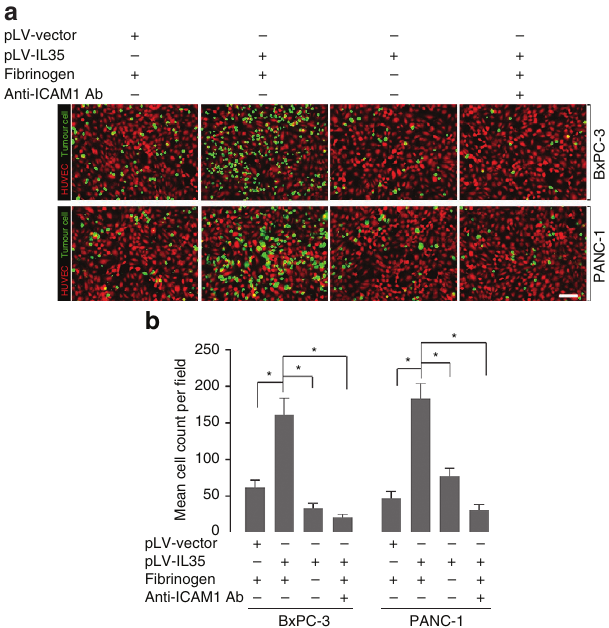
Figure 4 | ICAM1 facilitates adhesion to HUVECs via the ICAM1– fibrinogen–ICAM1 bridge. ( a , b ) HUVECs stained with a CytoPainter Cell Tracking Staining Kit (red) were pretreated with or without anti-ICAM1 antibody (10 m gml (cid:2) 1 ) for 30min. Calcein AM-labelled (green) IL-35- overexpressing or control tumour cells were added and then co-cultured with or without fibrinogen (0.88 m M) for 1h. The adhered tumour cells and HUVECs were captured by a fluorescence microscope ( a ). The average adhered tumour cells of five random fields of (cid:3) 100 magnification were calculated ( b ). Experiments were replicated three times; shown are the mean values ± s.d. Unpaired t -test was used; tests of significance are two-sided. * P o 0.05. Scale bars, 100 m